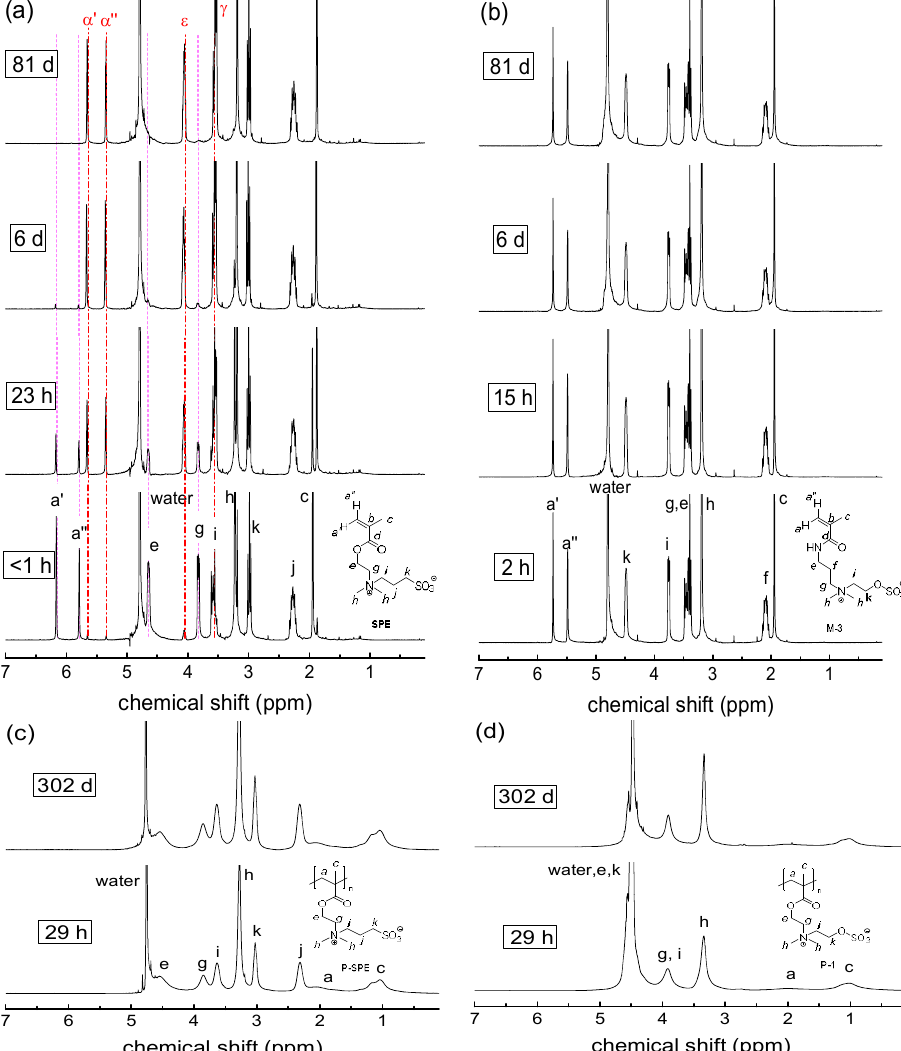
Figure 7. Evolution of the 1 H-NMR spectra over time illustrating the degradation behavior in carbonate buffer in D 2 O (pH = 10) at room temperature for: ( a ) SPE ; ( b ) M-3 , ( c ) P-SPE ; ( d ) P-1 . Signal attributions of the starting compounds are labeled by roman letters, signal attributions of the degradation product by corresponding Greek letters. Broken vertical lines are meant as guide to the eye.